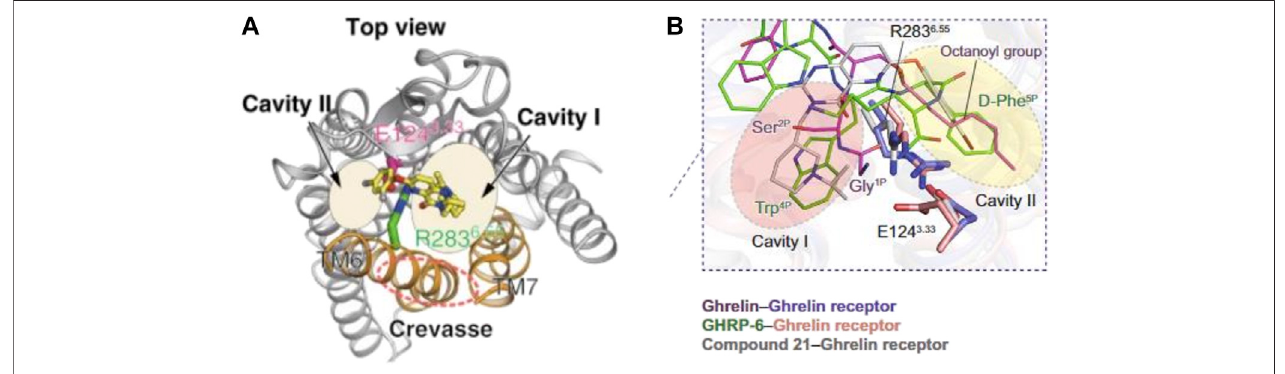
FIGURE 2 | Structure modelling of the ghrelin receptor whilst bound to ghrelin. Structures proposed by Shiimura et al. (2020) (A) and Wang et al (2021) (B) both identify the ligand-binding pocket of ghrelin receptor being bifurcated into two cavities. The model proposed in (A) presents the octanoyl group inserted in a crevasse near cavity 1. Whilst the model proposed in (B) locates the octanoyl group within the second cavity.